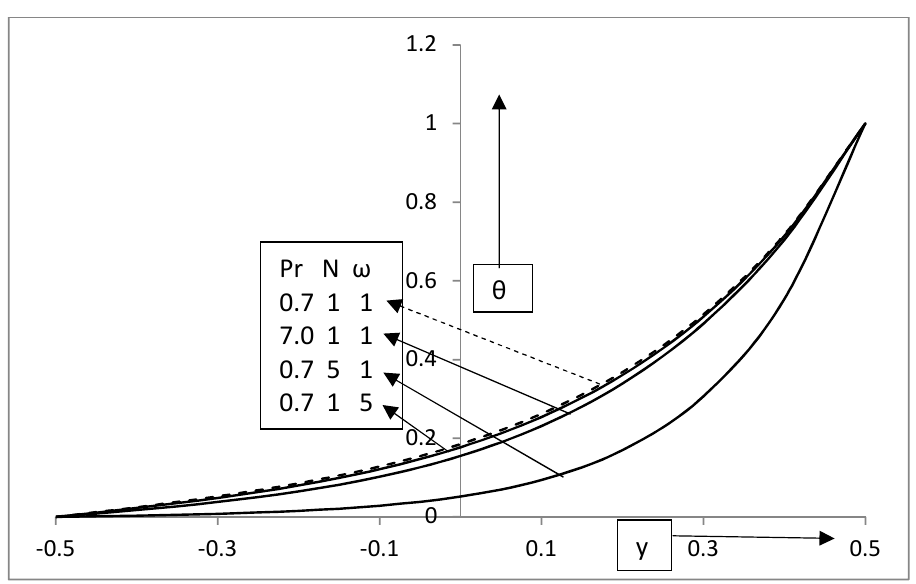
Figure 5. Temperature profiles for z=0.5 and t= π